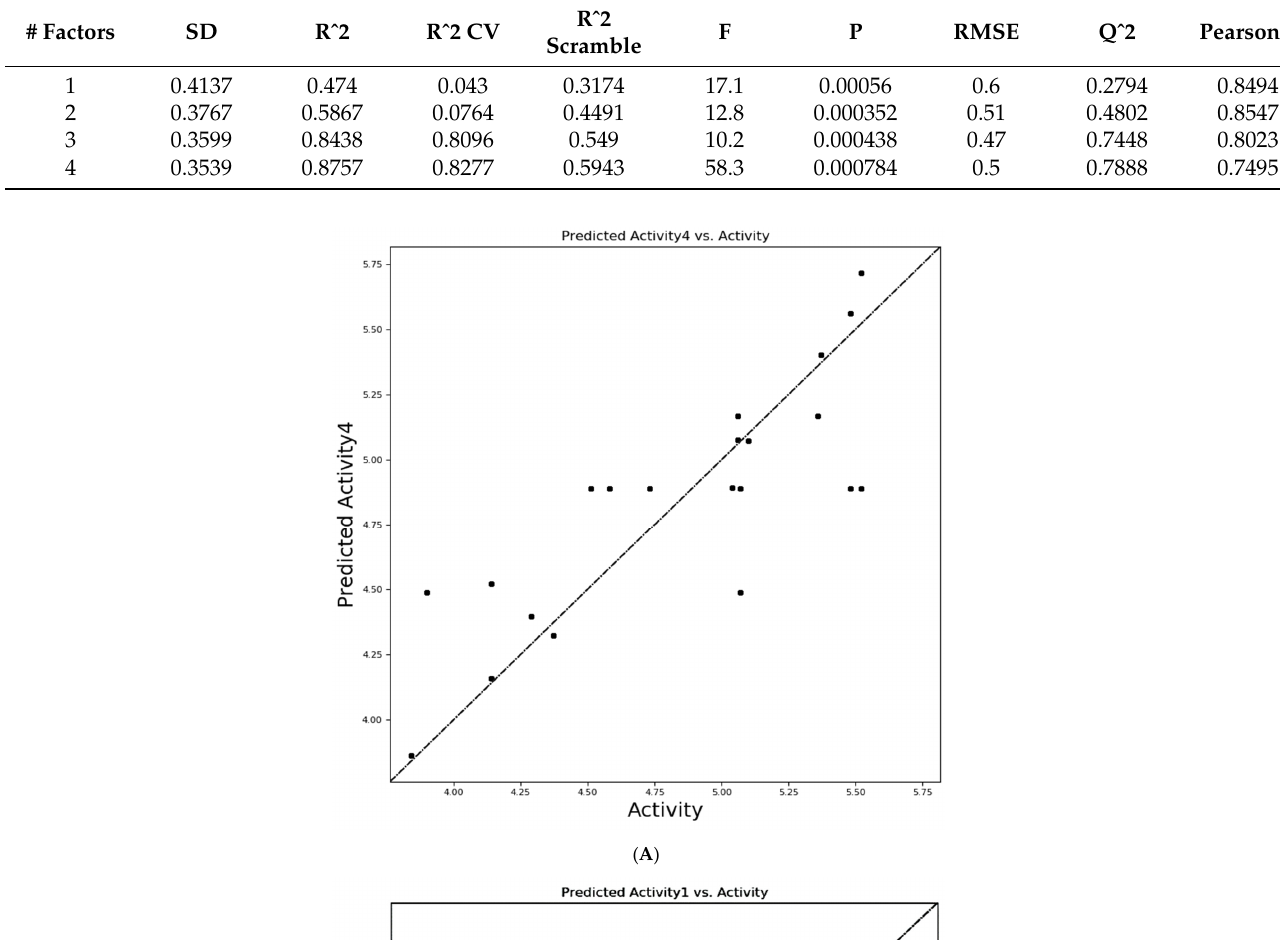
Table 3. Atom-based QSAR statistics with important values like Rˆ2, Qˆ2 and Rˆ2 CV.